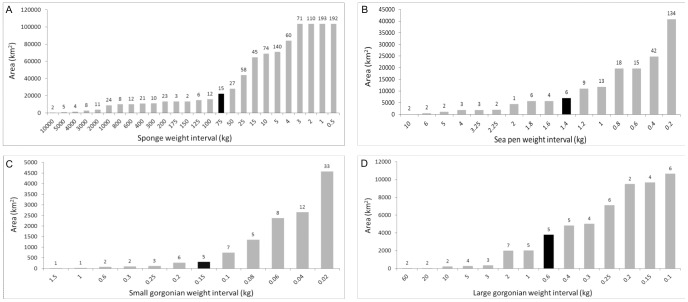
Histograms of the area occupied by successive weight thresholds of VME Indicator taxa.The numbers of additional point observations (over the preceding higher weight threshold) used to create each polygon are indicated above the each bar. A) Sponges. B) Sea pens. C) Small gorgonian corals. D) Large gorgonian corals.